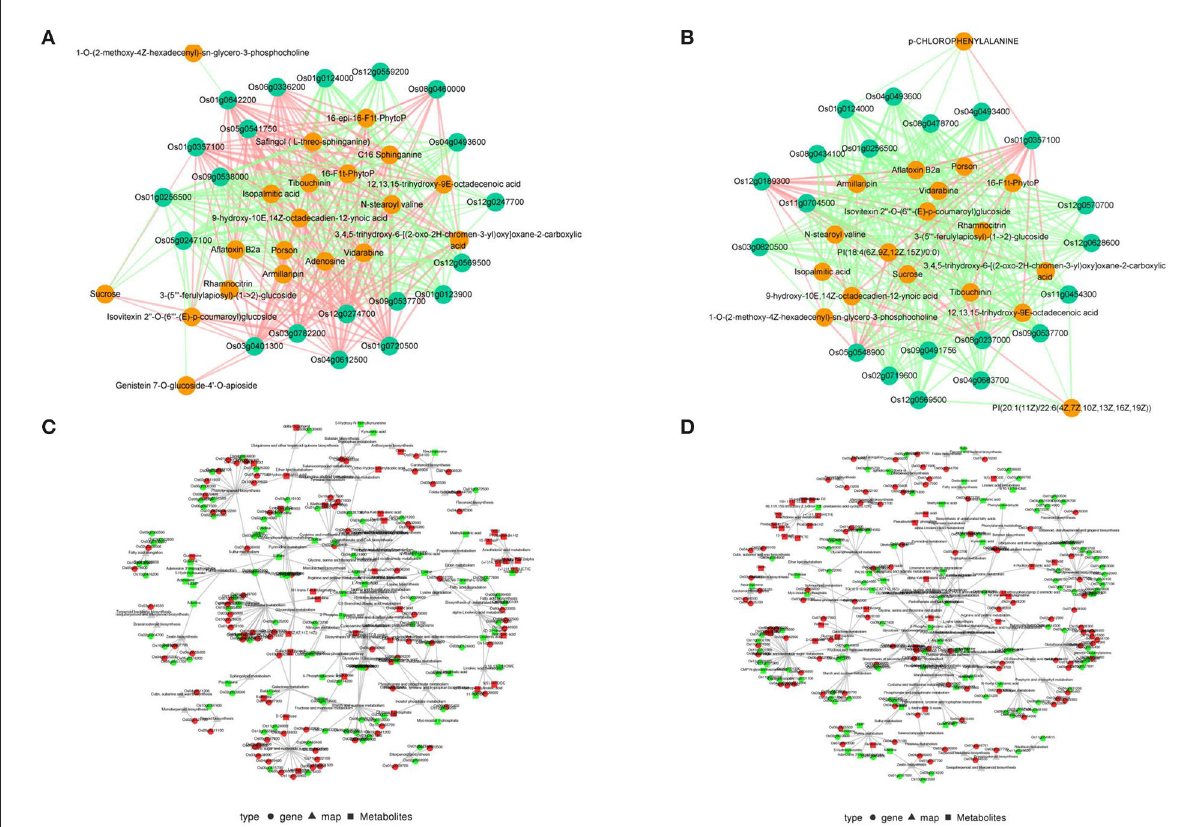
FIGURE5 Correlation analysis of differentially expressed genes (DEGs) and differentially abundant metabolites (DAMs) in response to salt stress. Cytoscape network of the top 20 DEGs and DAMs at (A) 3 and (B) 5 d after salt treatment, and the green solid circles represent genes while the orange solid circles represent metabolites, and the red lines represent positive correlations while the green lines represent negative correlations. Cytoscape network of DEGs and DAMs within the same Kyoto Encyclopedia of Genes and Genomes (KEGG) pathways at (C) 3 and (D) 5 d after salt treatment by using KEGG Markup Language